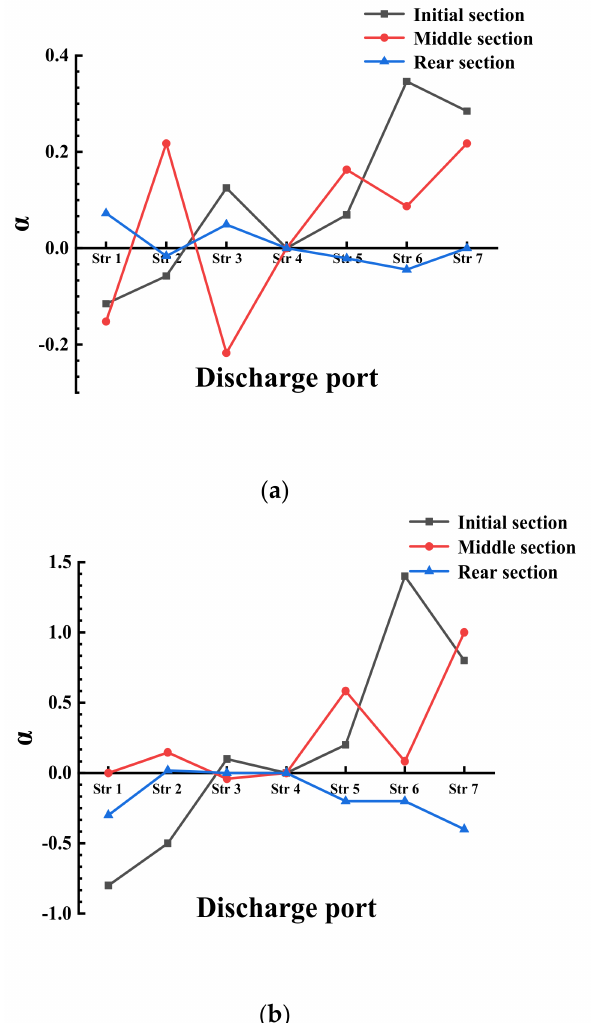
Figure 7. Temperature attenuation deviation characteristics of the thermal jet from the circle discharge port: ( a ) X-Axis; ( b ) Z-Axis.